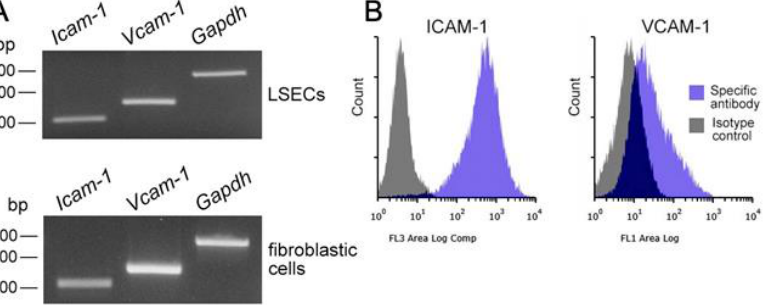
Figure 6. mRNA expression of integrin ligands in LSECs and fibroblastic cells, and their cell surface expression in LSECs. ( A ) mRNA expression of membrane proteins serving as integrin ligands (ICAM-1, VCAM-1) in primary LSECs and fibroblastic cells propagated using mixed culture with liver Mø. Both LSECs and fibroblasts clearly expressed Icam-1 and Vcam-1 . ( B ) Representative histograms analyzed using flow cytometry showing the cell surface expression of ICAM-1 and VCAM-1 in primary LSECs (blue histogram, specific antibody; gray histogram, isotype control). LSECs express ICAM-1 clearly while VCAM-1 is substantially expressed. Considering the findings in Figure 5, Kupffer cells likely adhere to LSECs via the β 2 integrins/ICAM-1 and α 4 β 1 and VCAM-1 interaction [21,22].